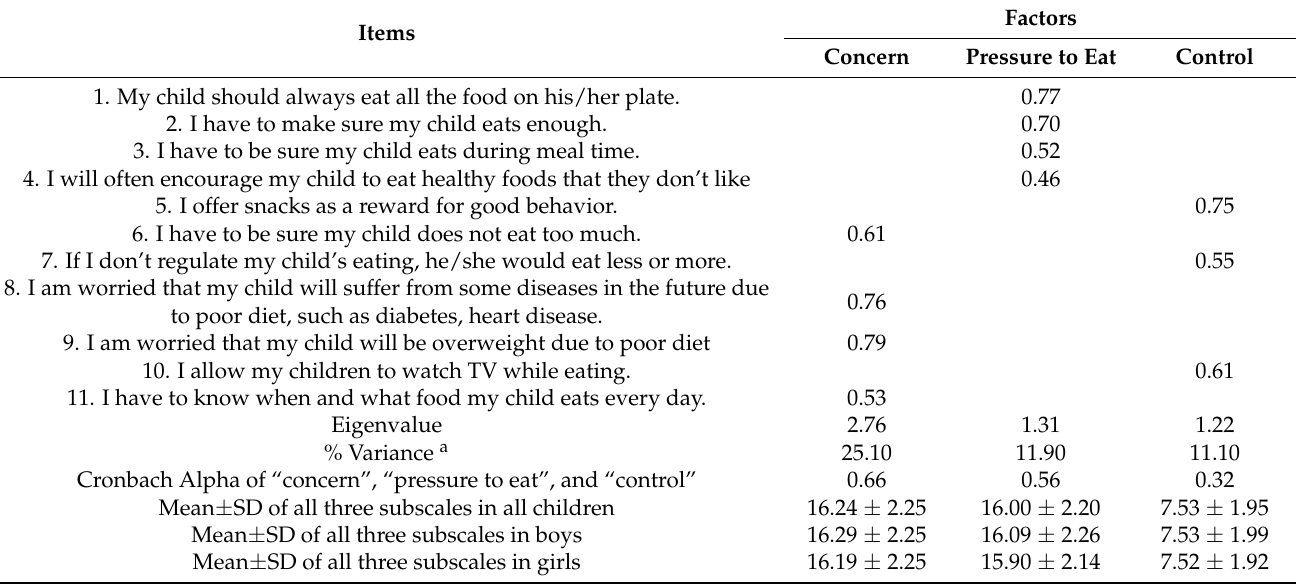
Table 1. Description of factors of parental feeding practices arising from factor analysis based on pooled baseline data during 2015 to 2017 from the Childhood Obesity Study in China Mega-Cities ( n =